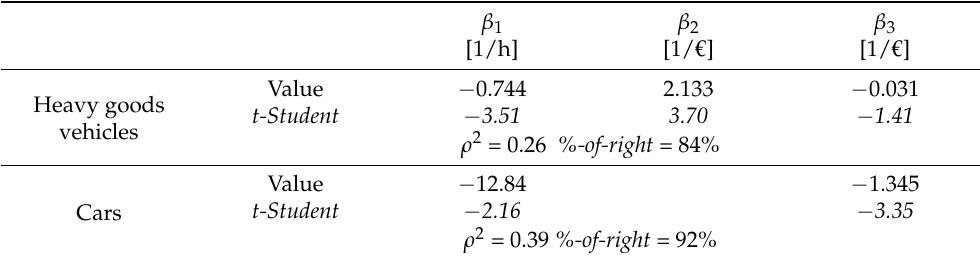
Table 1. Calibrated